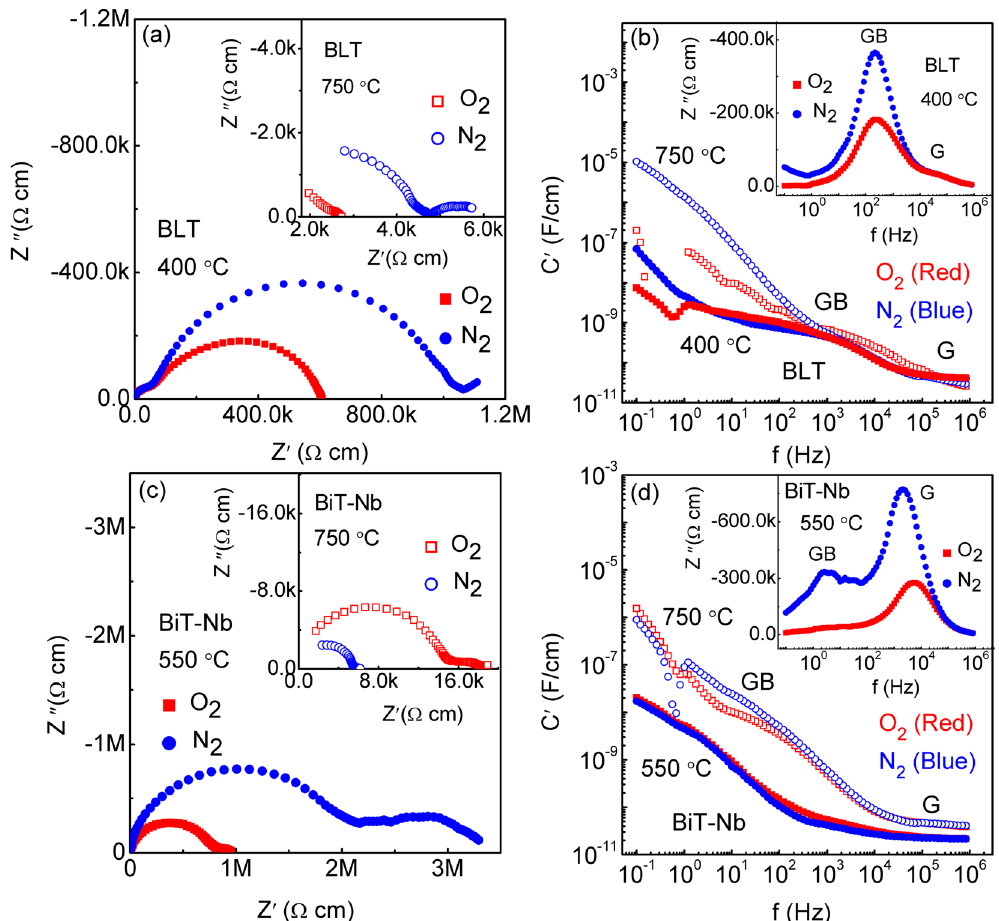
Figure 7. ( a ) 400 °C and 750 °C (inset) Z * plots of the O 2 - and N 2 -processed BLT samples. ( b ) 400 °C and 750 °C C ′ plots with an inset showing 400 °C Z ″ plots, of the O 2 - and N 2 -processed BLT samples. ( c ) 550 °C and 750 °C (inset) Z * plots of the O 2 - and N 2 - processed BiT-Nb samples. ( d ) 550 °C and 750 °C C ′ plots with an inset showing 550 °C Z ″ plots, of the O 2 - and N 2 -processed BiT-Nb